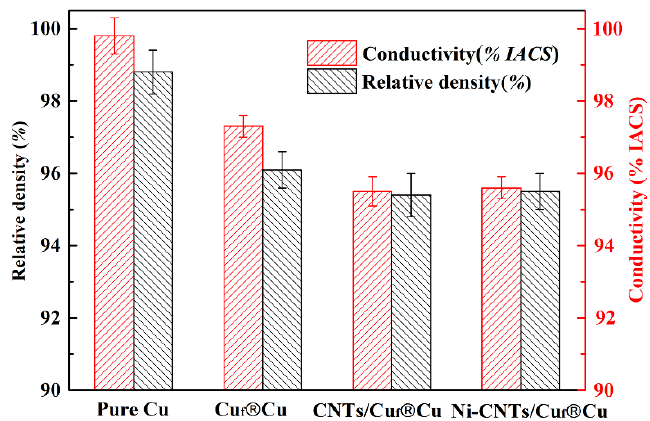
Figure 5. Electrical conductivity and relative density of pure Cu and the composites.